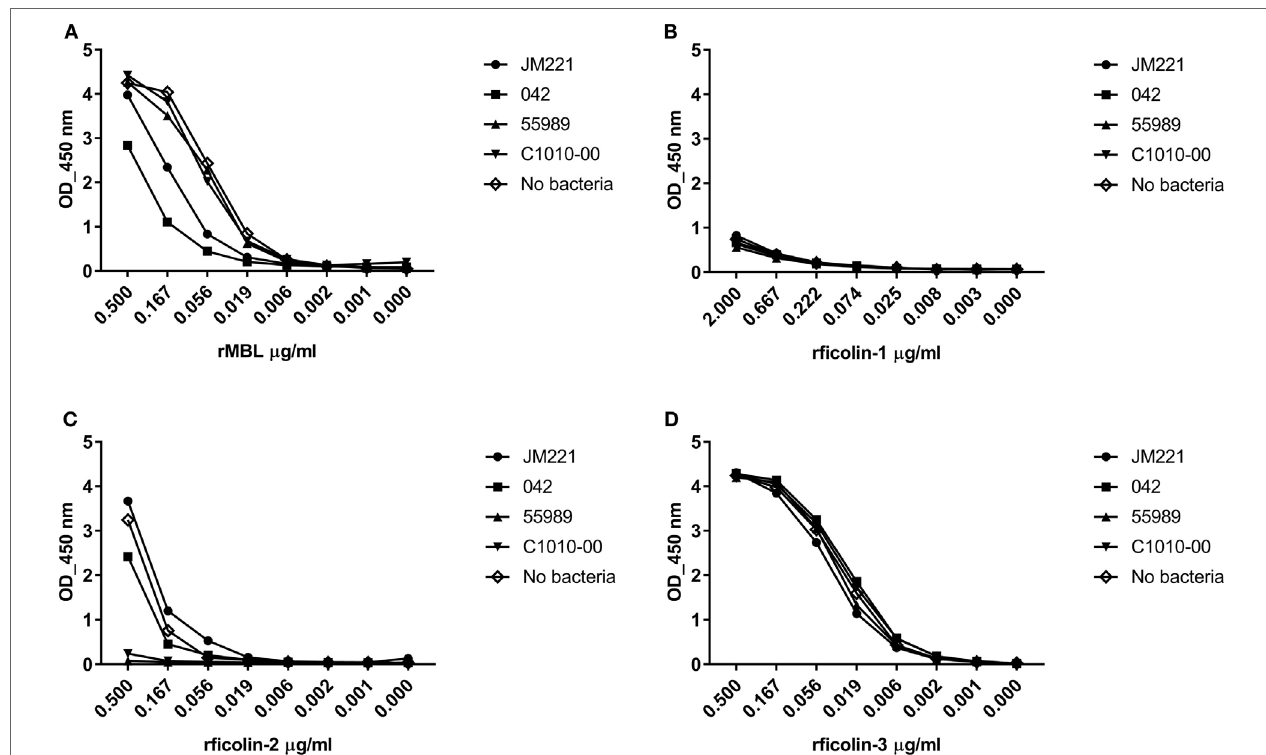
FigUre 1 | Consumption of recombinant MBL (rMBL), rficolin-1, -2, and -3 by prototypic EAEC strains. EAEC prototype strains JM221, 042, C1010-00, and 55989 were incubated with (a) rMBL (0.5 µg/ml), (B) rficolin-1 (2.0 µg/ml), (c) rficolin-2 (0.5 µg/ml), or (D) rficolin-3 (0.5 µg/ml) and the unbound protein fraction was transferred to wells coated with mannan or acetylated bovine serum albumin and detected by specific mAb against mannose-binding lectin (MBL), ficolin-1, -2, or